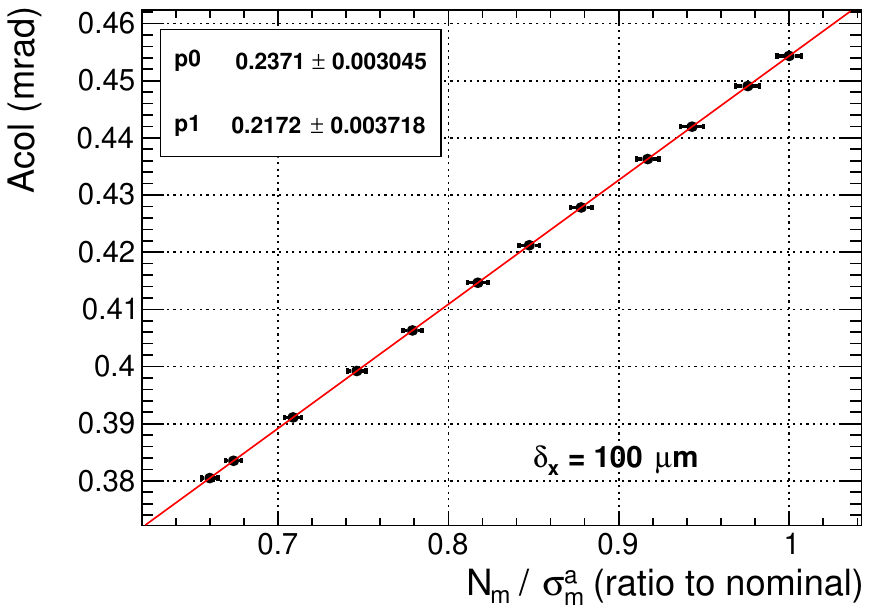
Figure 15 . Acollinearity Acol expected for leading-order Bhabha events at each step of the ramp- up, in presence of a misalignment of 100 (cid:22) m of the luminometer system along the x direction, as a function of the average bunch intensity divided by the average bunch length to the power of a = 0 : 72. The errors on the points represent the statistical uncertainties obtained from 40 seconds of data at each point. The result of a linear (cid:12)t is overlaid and the (cid:12)tted slope ( p 1) and intercept ( p 0) are shown together with their uncertainties, the (cid:12)tted values being equal to Acol the input Acol by construction. misalign